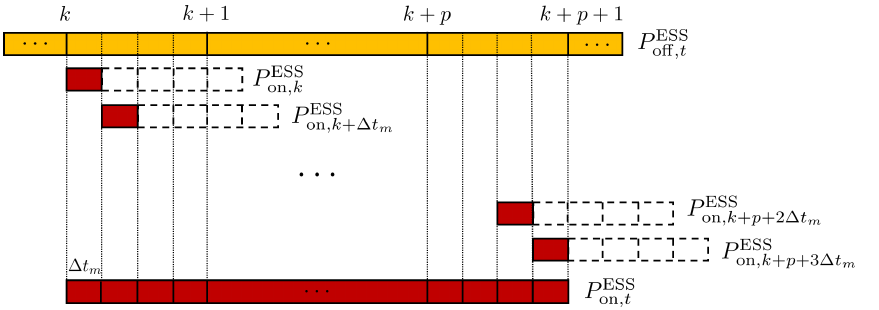
Figure 5. Online ESS operation